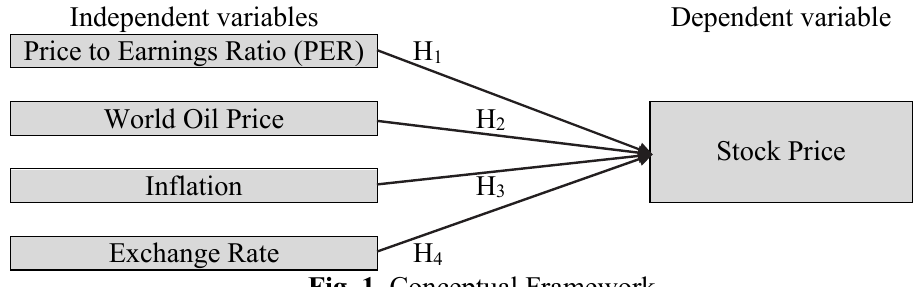
Fig. 1. Conceptual